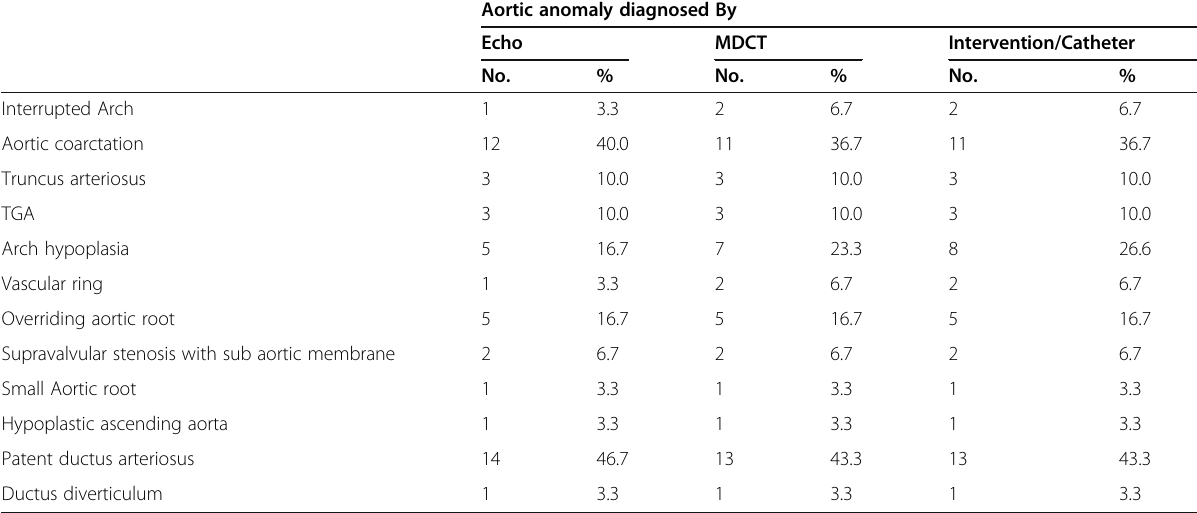
Table 1 Thoracic aortic anomaly diagnosed by Echo, MDCT, and intervention/catheter Aortic anomaly diagnosed By